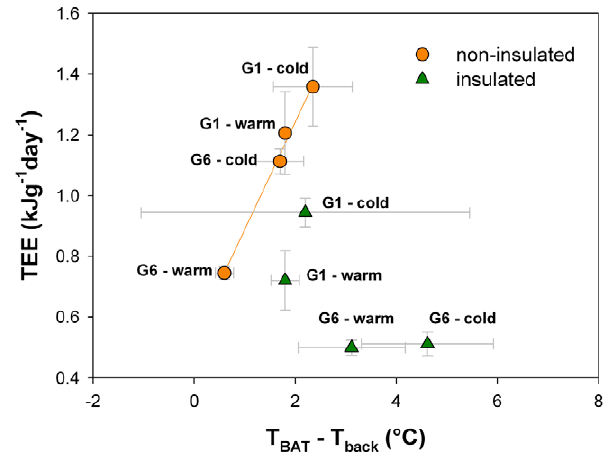
Figure 5. Total energy expenditure (TEE) as a function of surface temperature difference between brown adipose tissue (T BAT ) and back (T back ). G1 stands for isolated pups and G6 for huddling pups, non-insulated (circle) or insulated (triangle). Regression line is statistically significant for non-insulated pups only: TEE=0.534 + 0.354*(T BAT - T back ), r 2 =0.991, F 1,3 =223.9,